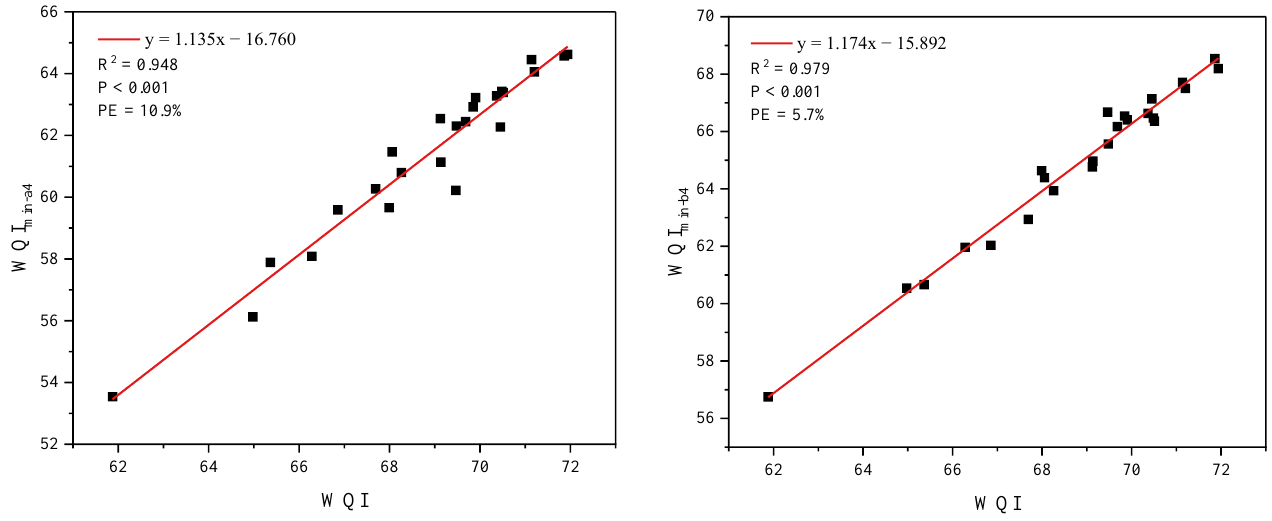
Figure 6. Comparison of the WQI and WQI min values based on the testing dataset (n = 24).